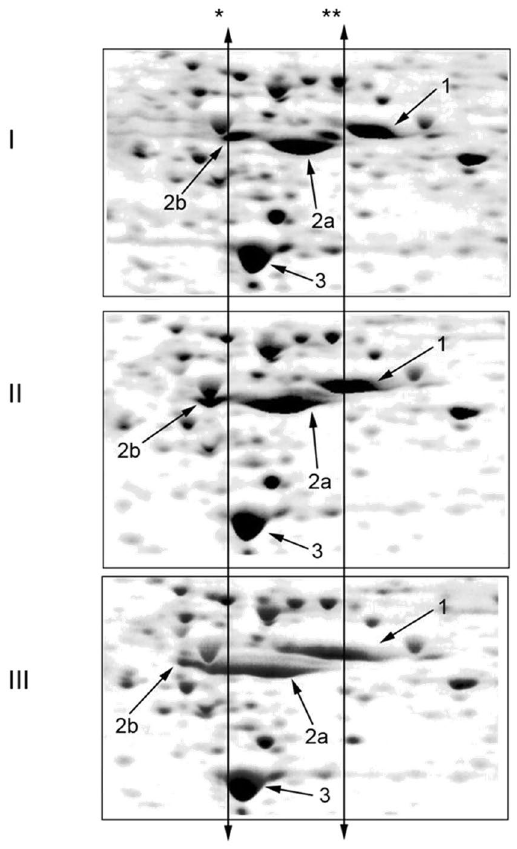
Figure 3. Visualization of changes in the isoelectric points of tubulin proteins after SH-SY5Y cells were treated with A β 42 and isoA β 42 peptides (10 μ M, 6 h). 35 S-labelled proteins from control SH-SY5Y cells ( I ) and cells treated with A β 42 ( II ) or isoA β 42 ( III ) were separated by 2D electrophoresis. The double arrow shows * the position of the acid end of β -tubulin in the control cells and ** the position of α -tubulin in the control cells. Protein identification: 1 - α -tubulin; 2a - β -tubulin (TBB5); 2b - β -tubulin (TBB4); 3-– actin